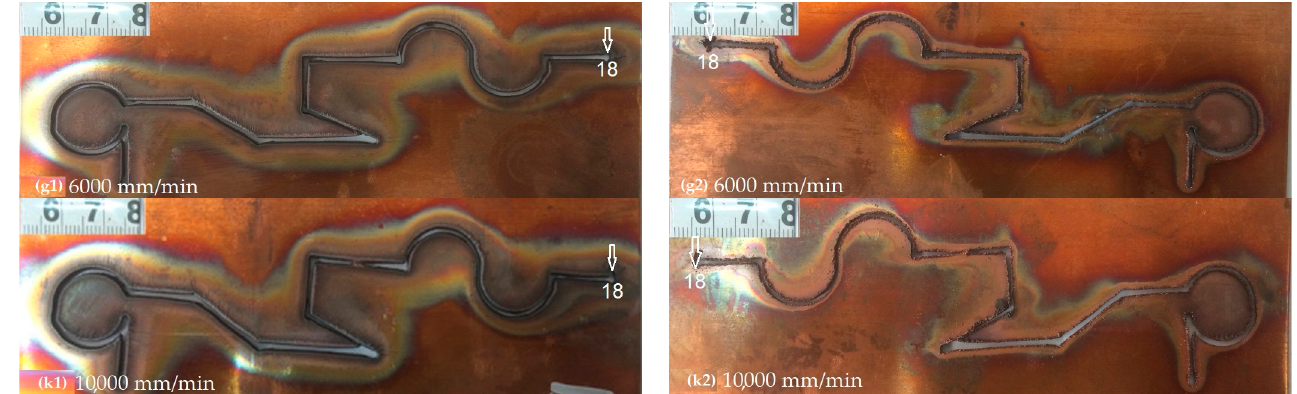
Figure 12. At 30 A, the cutting path width of ( g1 , g2 ) at 6000 mm/min for Point 18 compared to ( k1 , k2 ) at 10,000 mm/min.